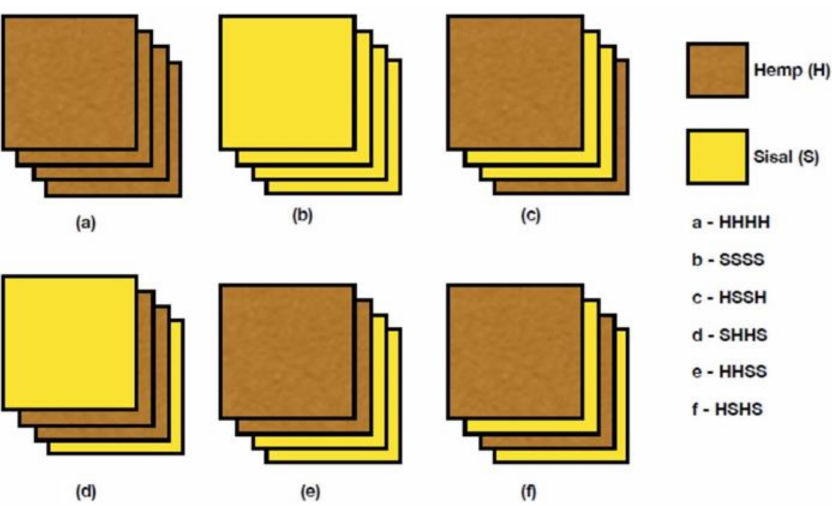
Figure 10. Different layering arrangements of sisal and hemp fiber mats [104]. Reproduced